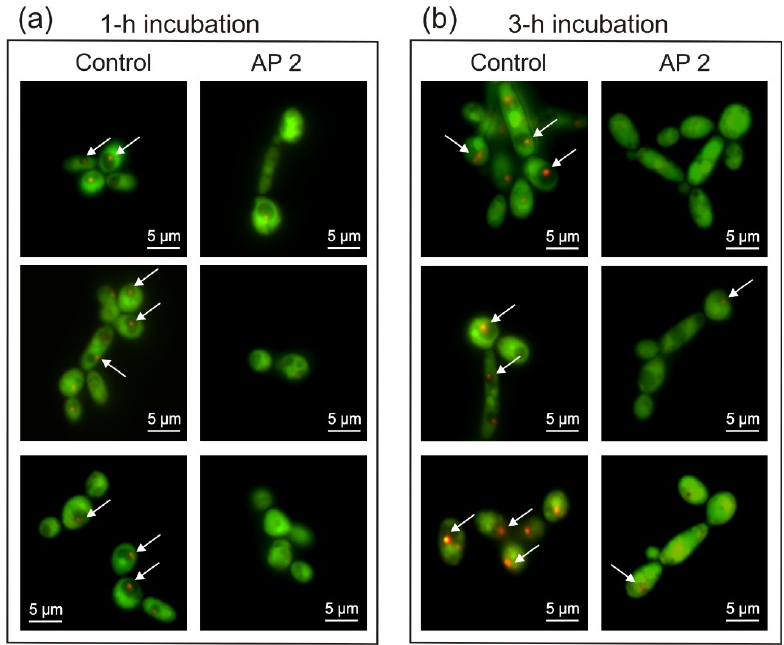
Figure 1. Survival rate of intact C. albicans cells and protoplasts treated with anionic peptide 2 (AP2). The log-phase intact cells or protoplasts (approximately 1 × 10 3 colony-forming units (CFU)) were incubated without (control) or in the presence of 5 µ M AP2 at 37 ◦ C. Then, the cells were plated onto solid YPD medium and the grown colonies were counted. Statistical analysis was performed using One-way ANOVA (the compliance of the experimental data with the normal distribution and homogeneity of variance have been previously verified successfully). The results are presented as ± SD from three independent experiments. Statistical significance: * p < 0.05, ** p ≤ 0.01 (AP2-treated intact cells and protoplasts versus control intact cells and protoplasts, respectively). Survival of cells incubated without the peptide was considered as 100%.